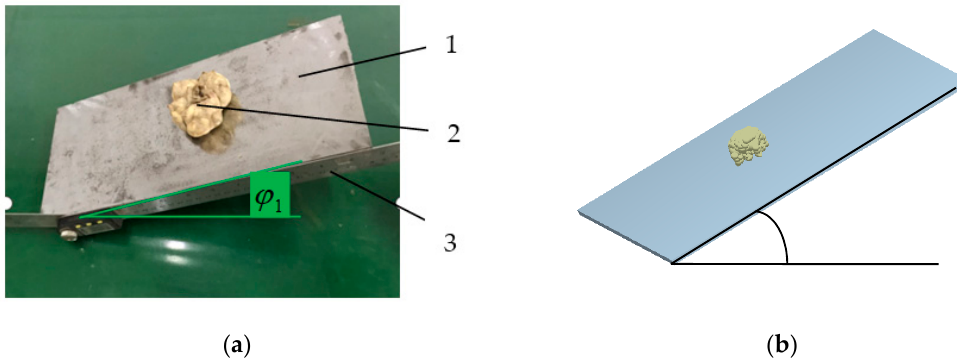
Figure 5. Calibration experiment of static friction coefficient. ( a ) Physical experiment; ( b ) Simulation test. 1. Q235 steel; 2. Lily Bulb; 3. Digital display angle ruler.